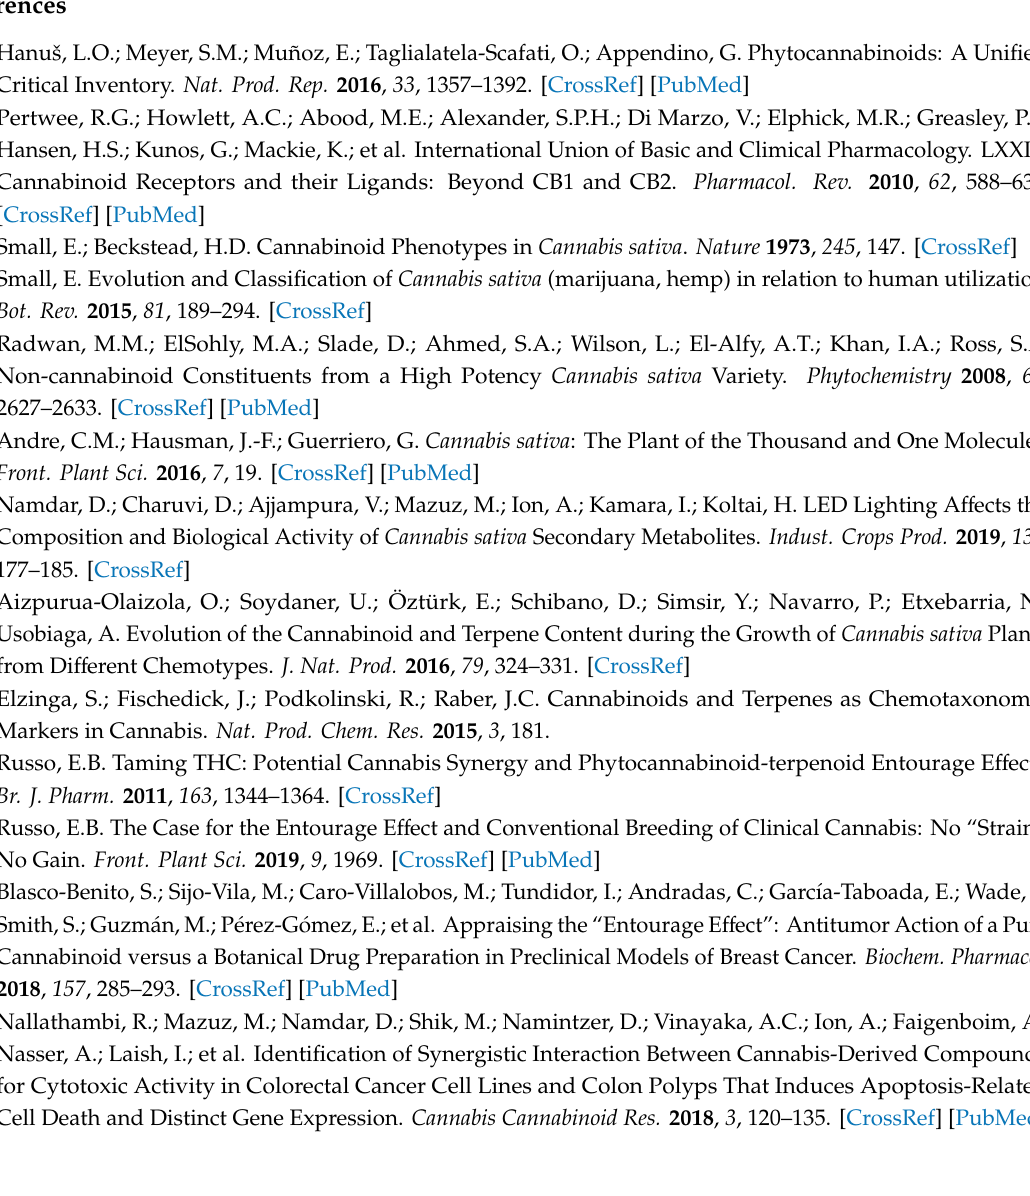
Supplementary Table S2: Statistical correlation between terpenoids and phytocannabinoids in the di ff erent strains analyzed. Supplementary Table S3: Summary of the e ff ective cell death response based on cannabinoids-terpenoids correlation ratios /